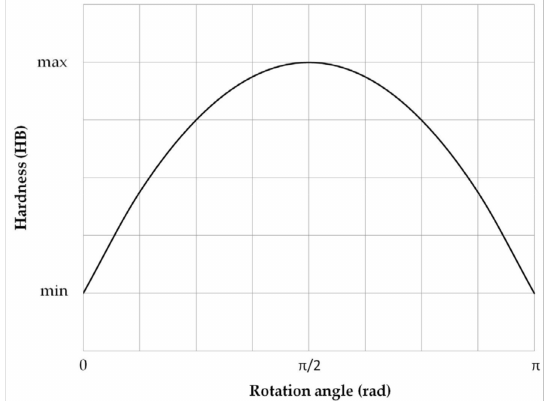
Figure 2. Distribution of material hardness over the diameter of the CBRTB in function of the rotation